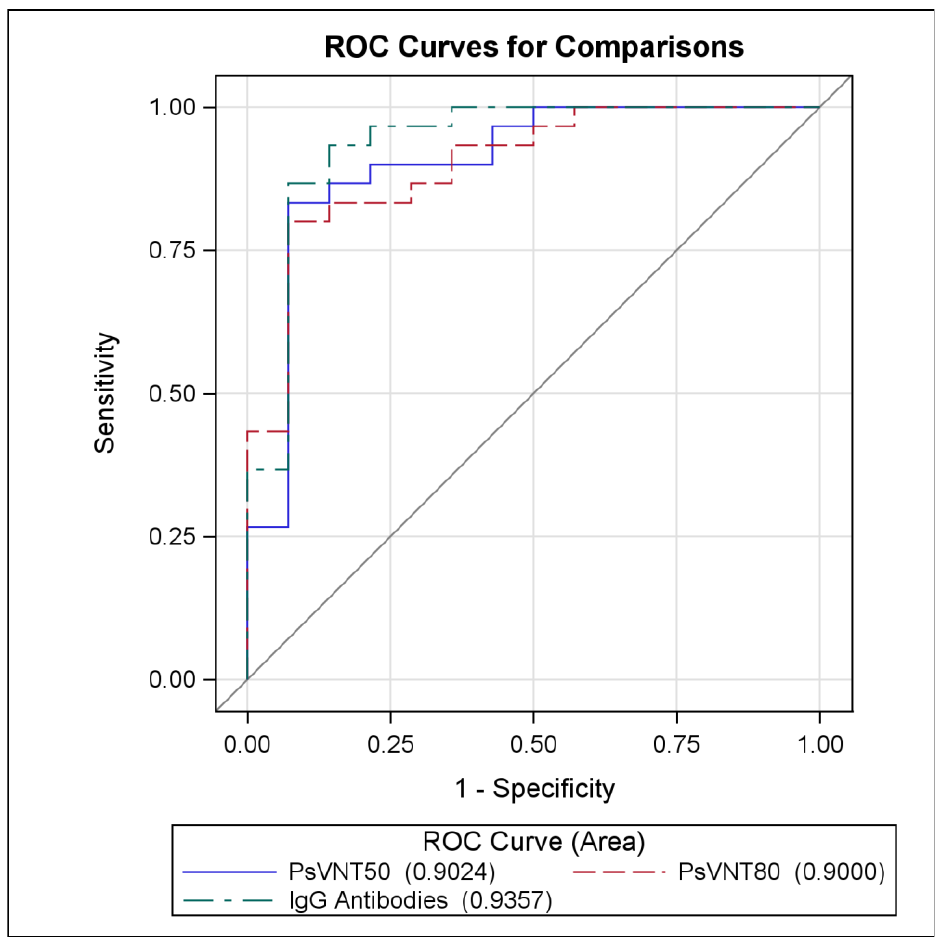
Figure 1. Comparison of ROC curves for the four models. ROC curves for the four models are similar. To further support the use of anti-GP IgG antibodies as a CoP, models with the log10 transformed immunization dose in addition to the log10 transformed immune response were fitted to the data. If the effect of the log10 transformed dose is not statistically significant, and the prediction model without log10 transformed dose is similar to the prediction model with log10 transformed dose, then the use of the immune response alone is supported. In this case, the dose does not significantly improve the model fit once the immune response is known, as the main effect of dose is through the immune response correlate. The model was initially fit including the interaction between log10 transformed dose and log10 transformed immune response. This interaction was